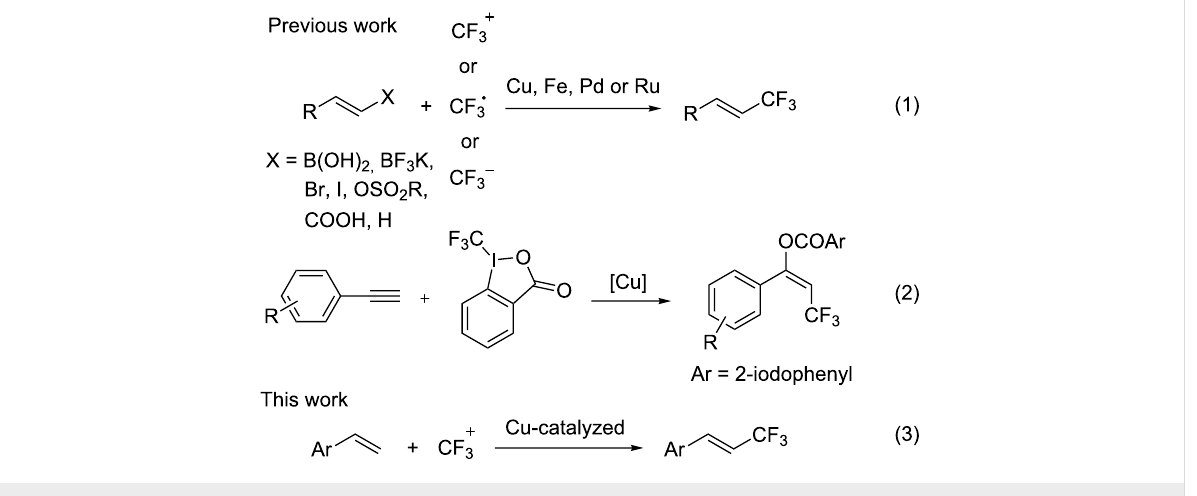
Scheme 1: Construction of the C vinyl –CF 3